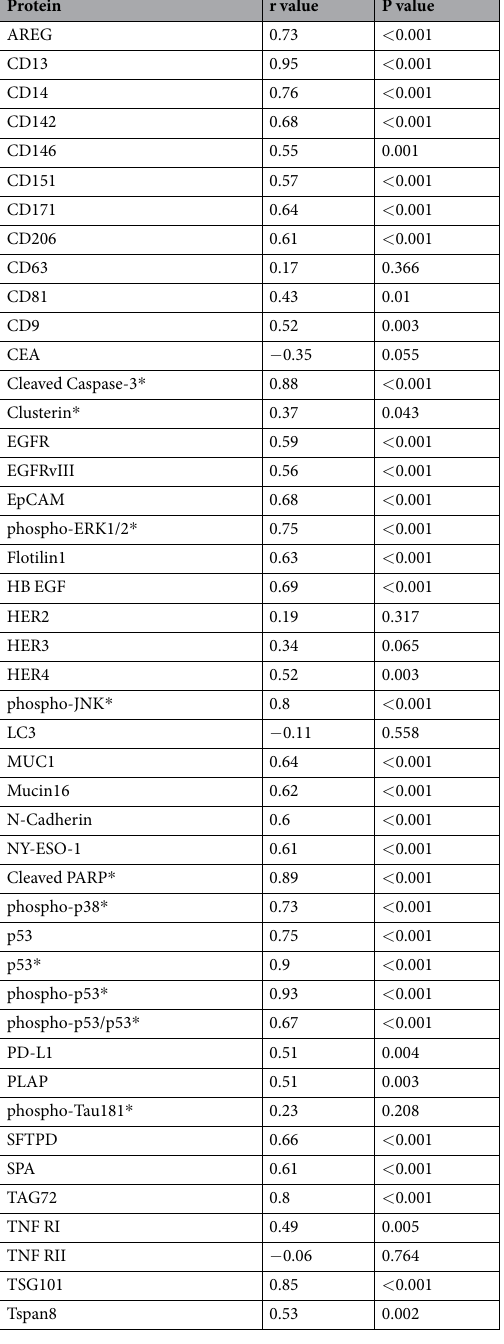
Table 3. Correlation of EV protein levels between visit 1 and visit 2. EV proteins levels were analyzed by EV array or by ELISA (indicated by * ). Protein levels between visit 1 and visit 2 were compared by Pearson correlation